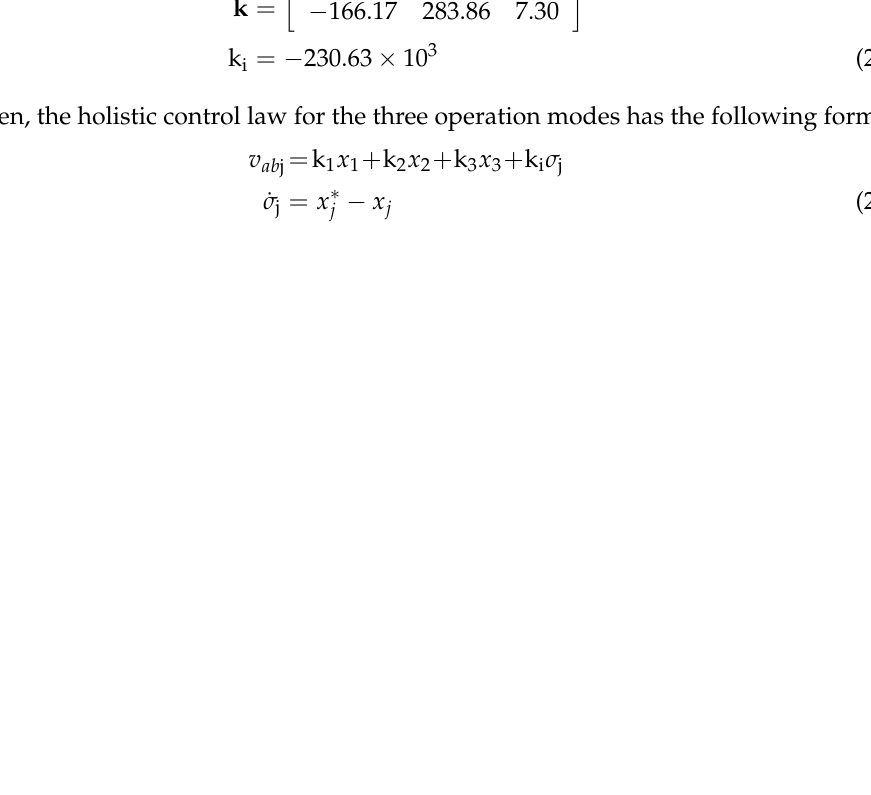
Figure 6 pinpoints the eigenvalue displacement from open loop to closed loop, keeping its semicircle shape according to Figure